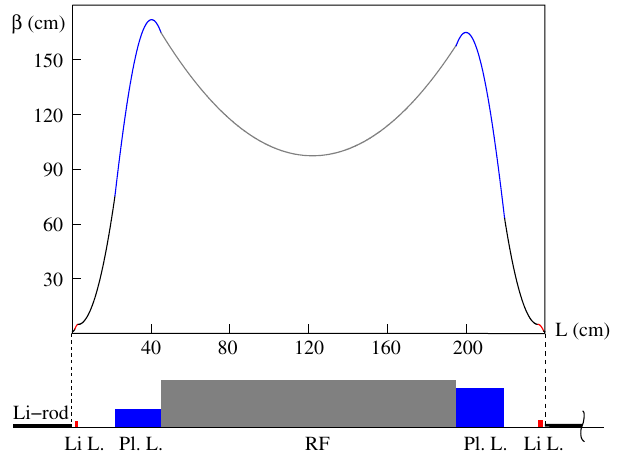
FIG. 1. Example of the beta-function behavior in one period of the cooling